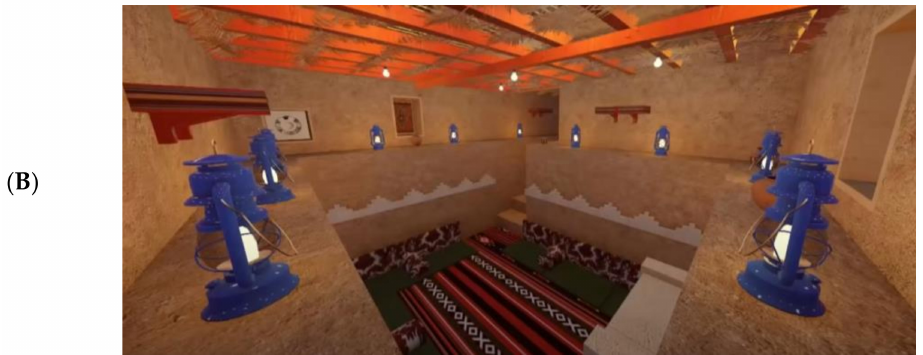
Figure 4. ( A ) View of actual room model showing the 0.6 m elevation aboveground level for naturel ventilation, and ( B ) night view of the room with traditional furniture, designed by Mohammed Al-Amoodi.